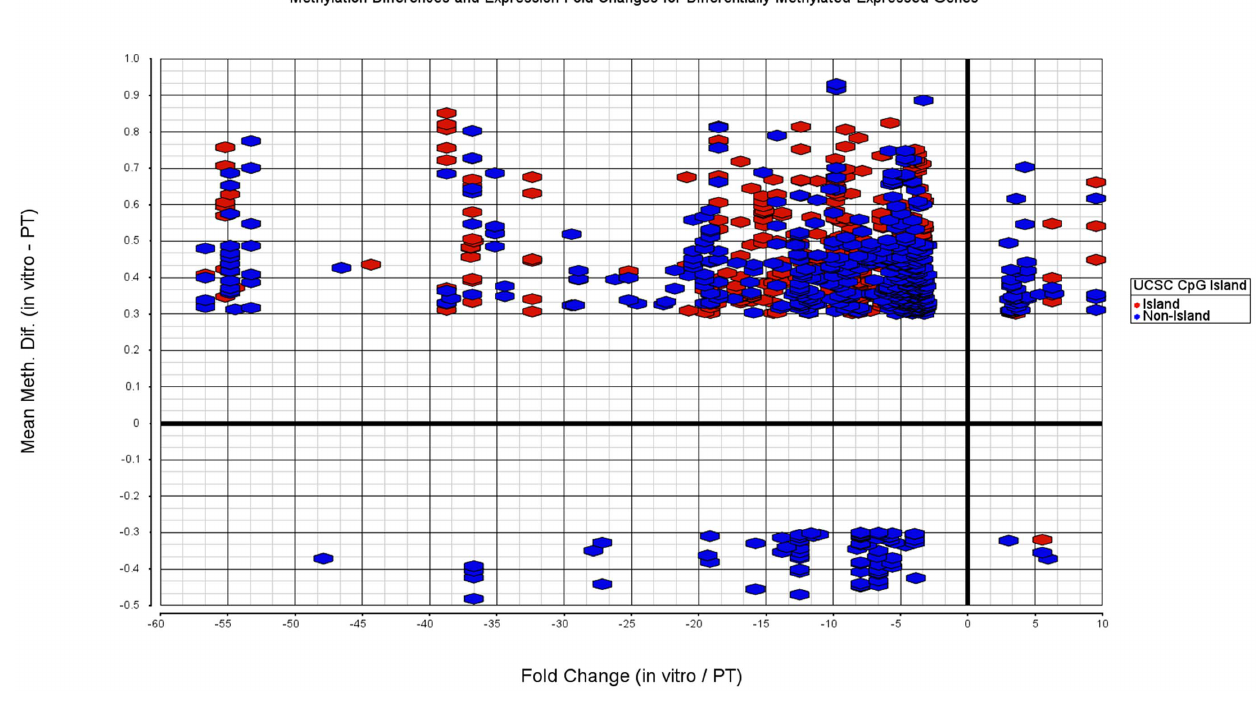
Figure 5. Fold changes (x-axis) and mean methylation differences (y-axis) between paired invitro -PT pairs for both differentially expressed and differentially methylated genes. Differentially expressed genes determined with paired t-test. Genes with false discovery rate less than 0.05 (Benjamini-Hochberg) and absolute fold change greater than three are used. Differentially methylated sites determined with paired non-parametric Quade test and sites with false discovery rate less than 0.05 (Benjamini-Hochberg) and absolute methylation difference greater than 0.3 are used.